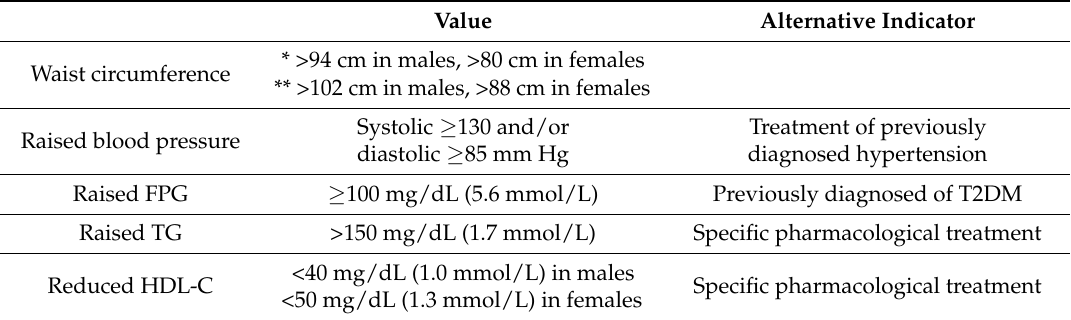
Table 1. Risk factors for the clinical diagnosis of metabolic syndrome.